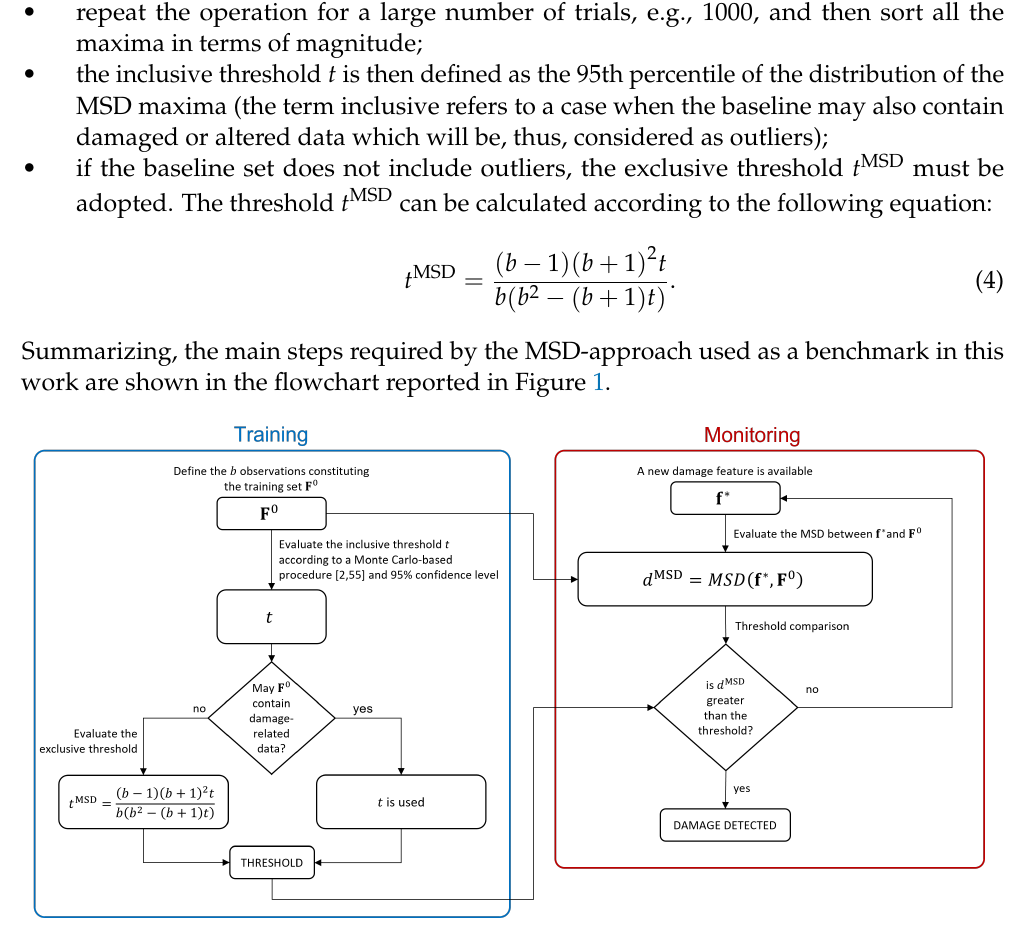
Figure 1. Flowchart of the MSD-based